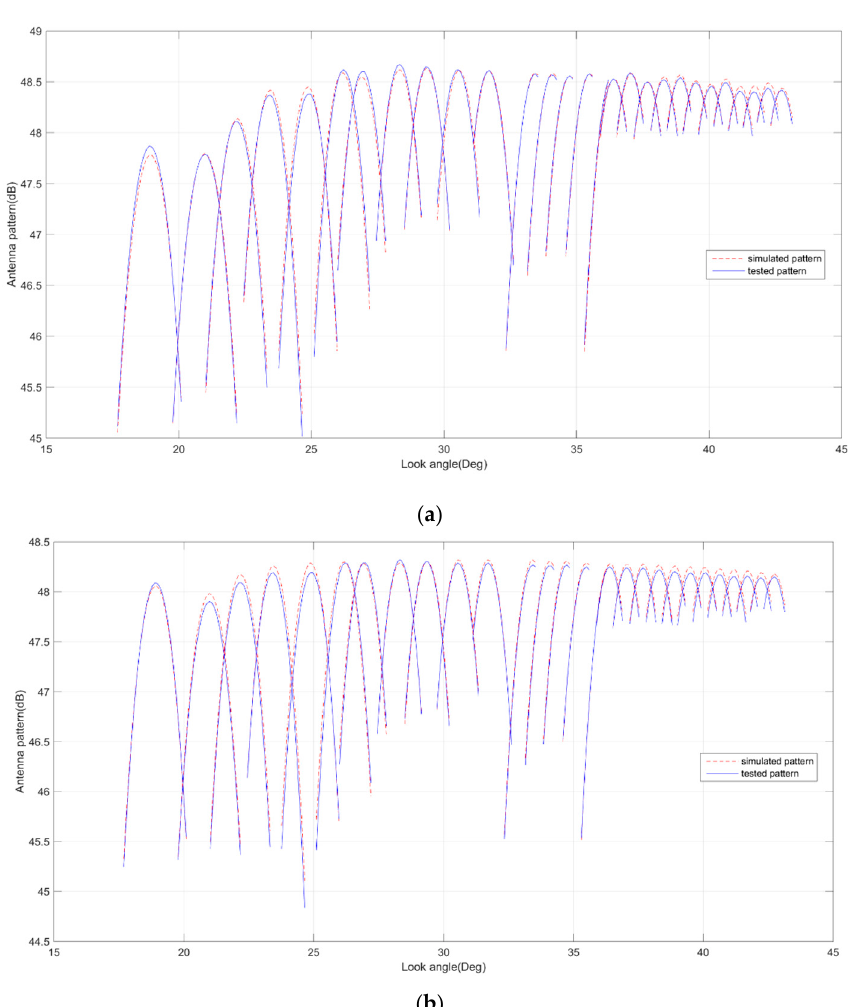
Figure 6. Comparison of simulated and tested patterns of Q mode within the valid main lobe range.